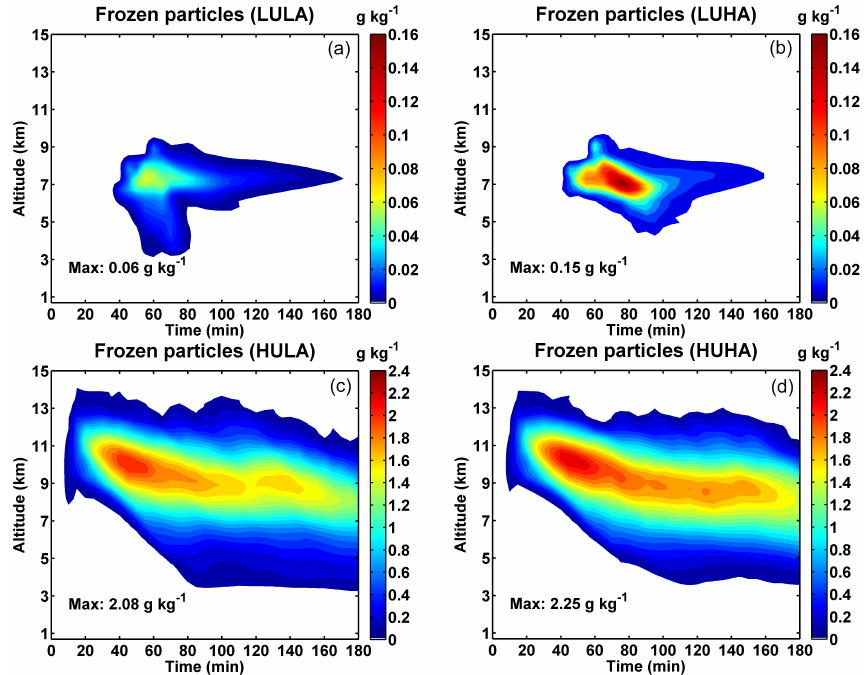
Figure 10. Same as Fig. 6 but for the frozen particles.